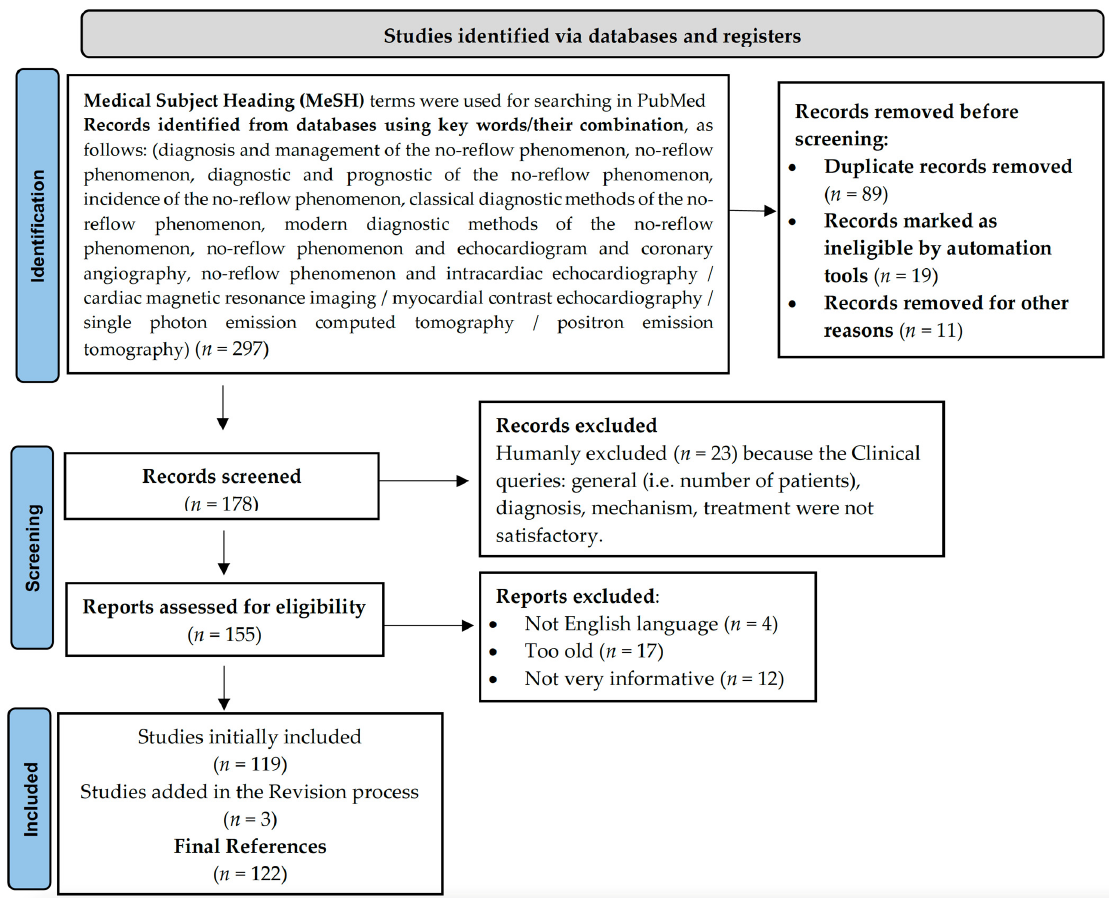
Figure 1. PRISMA 2020 flow diagram describing literature selection.